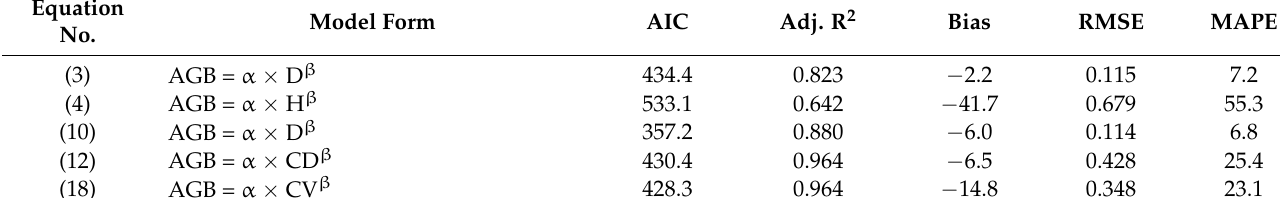
Model set 1: Compound predictor variables including D, H and ρ